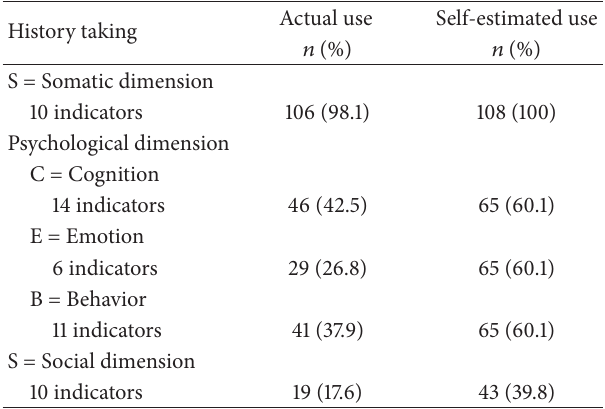
Table 1: Use of biopsychosocial history taking according to the SCEBS method: number of quality indicators (appendix) and num- ber and percentage scores for actual and self-estimated use by man- ual physical therapists ( 𝑛 = 20) in patients with back or neck pain ( 𝑛 =